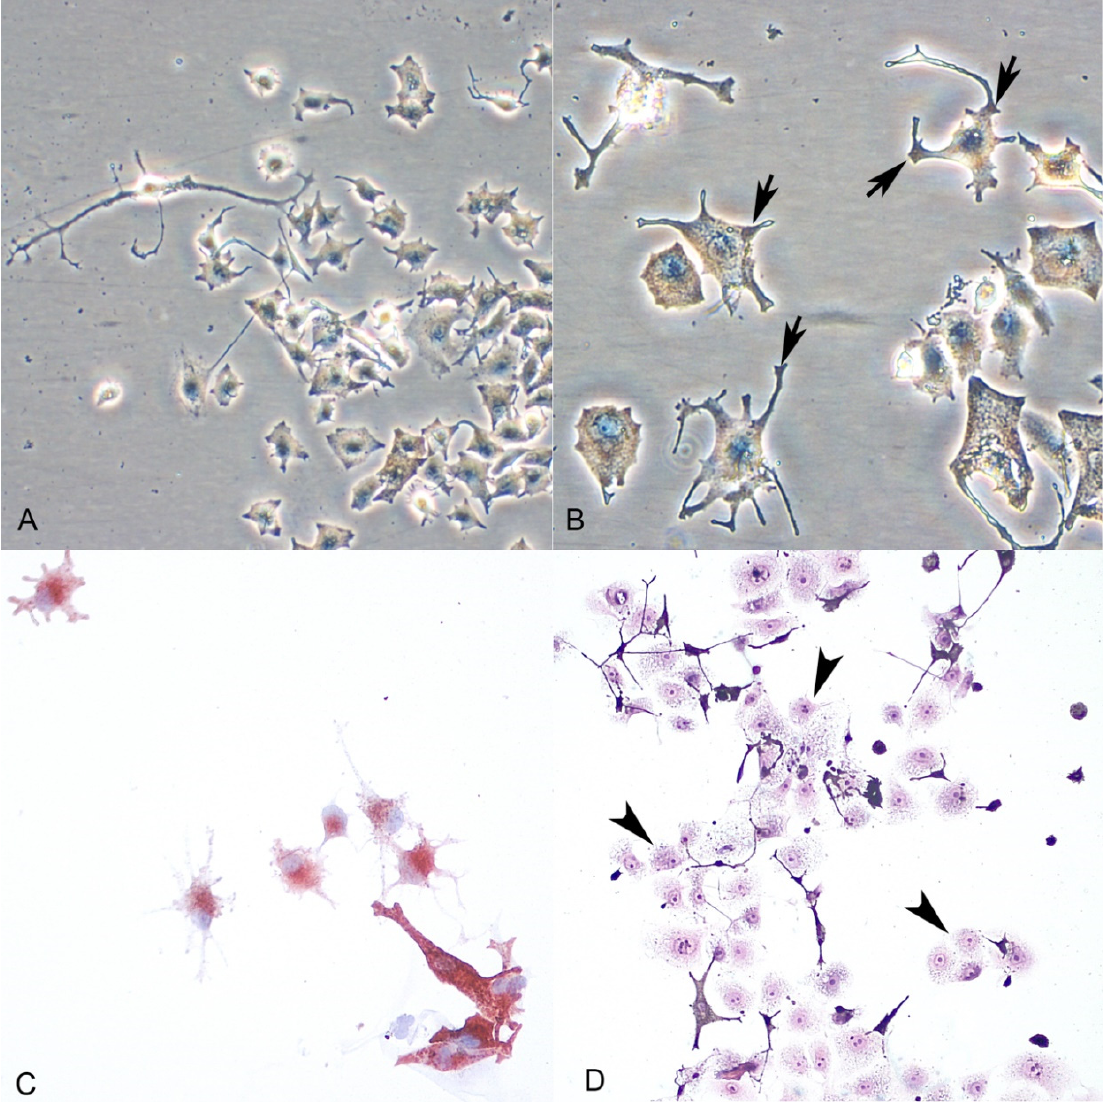
Figure 3. ( A , B ): Normal melanocytes (phase-contrast microscopy). Melanocytes show dendritic morphology and the presence of granules of melanin (arrows) within the cytoplasm. ( C ): Cytoplasmic immunolabeling of the cells with the anti-Melan A antibody confirmed melanocytic origin. ( D ): Keratinocyte contamination during the first days of culture (arrowheads) (H-E stain).